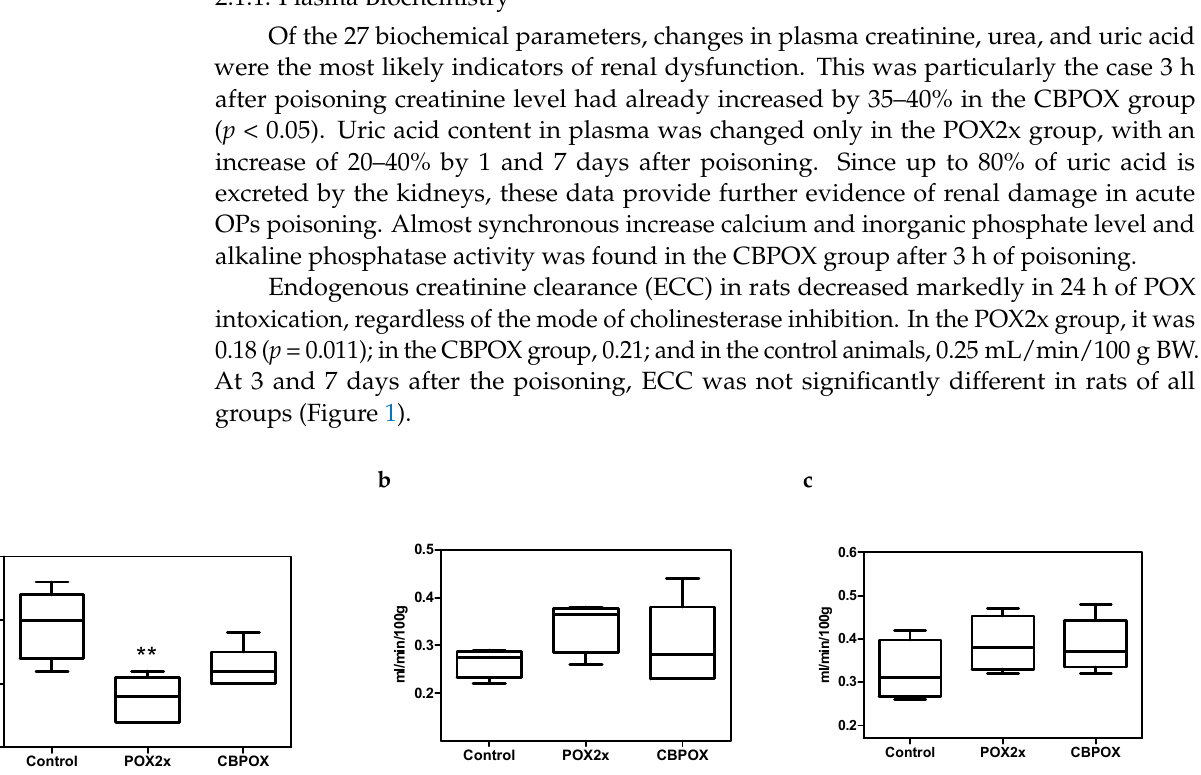
Figure 1. Endogenous creatinine clearance in rats: ( a ) 1 day, ( b ) 3 days, and ( c ) 7 days after the poisoning; ** p < 0.01 compared to Control group.